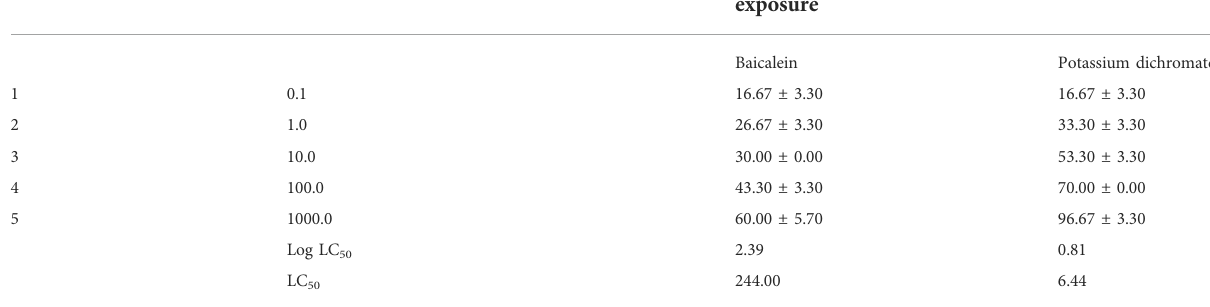
TABLE 1 Brine shrimp lethality assay for baicalein. S.no